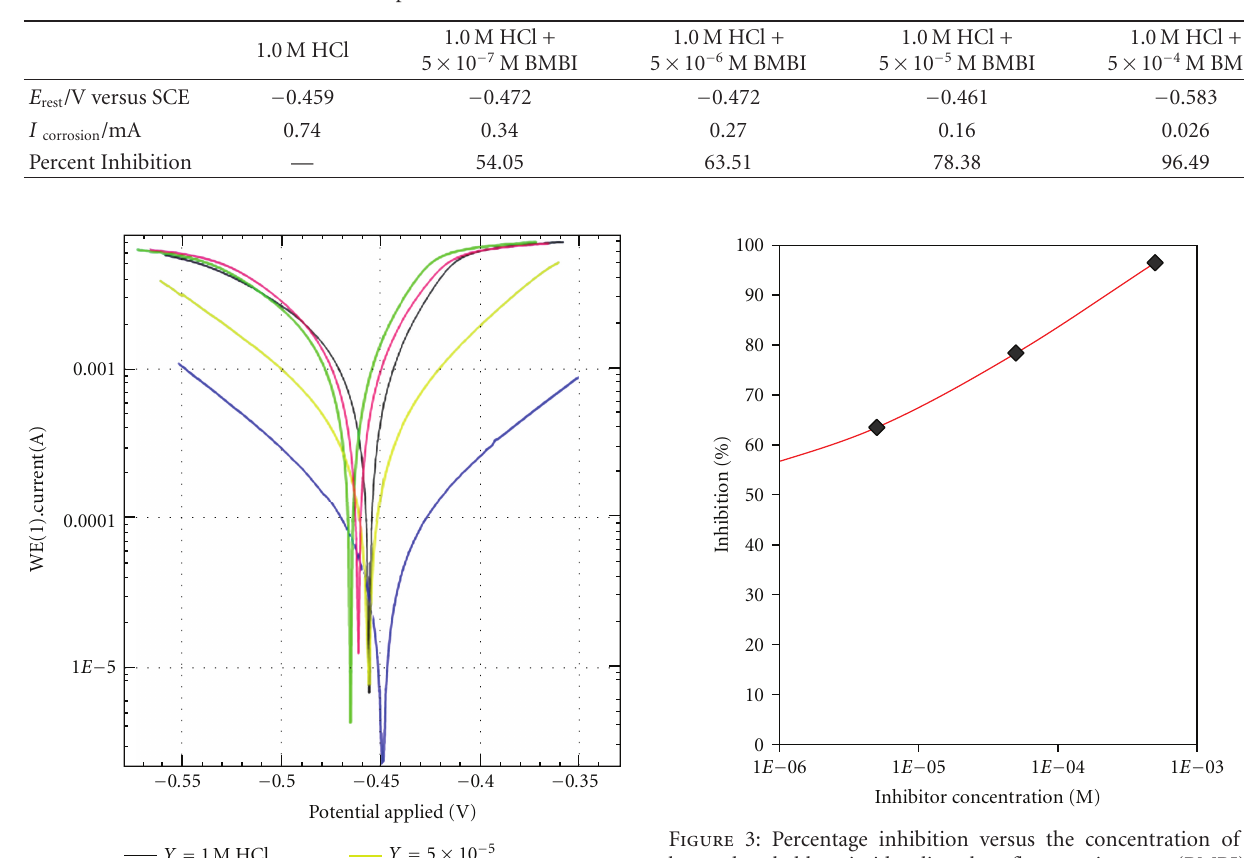
Table 1: Tafel corrosion currents and percent inhibitions of 3-benzoylmethyl benzimidazolium hexafluoroantimonate (BMBI) at various concentrations in 1.0M HCl at room temperature.